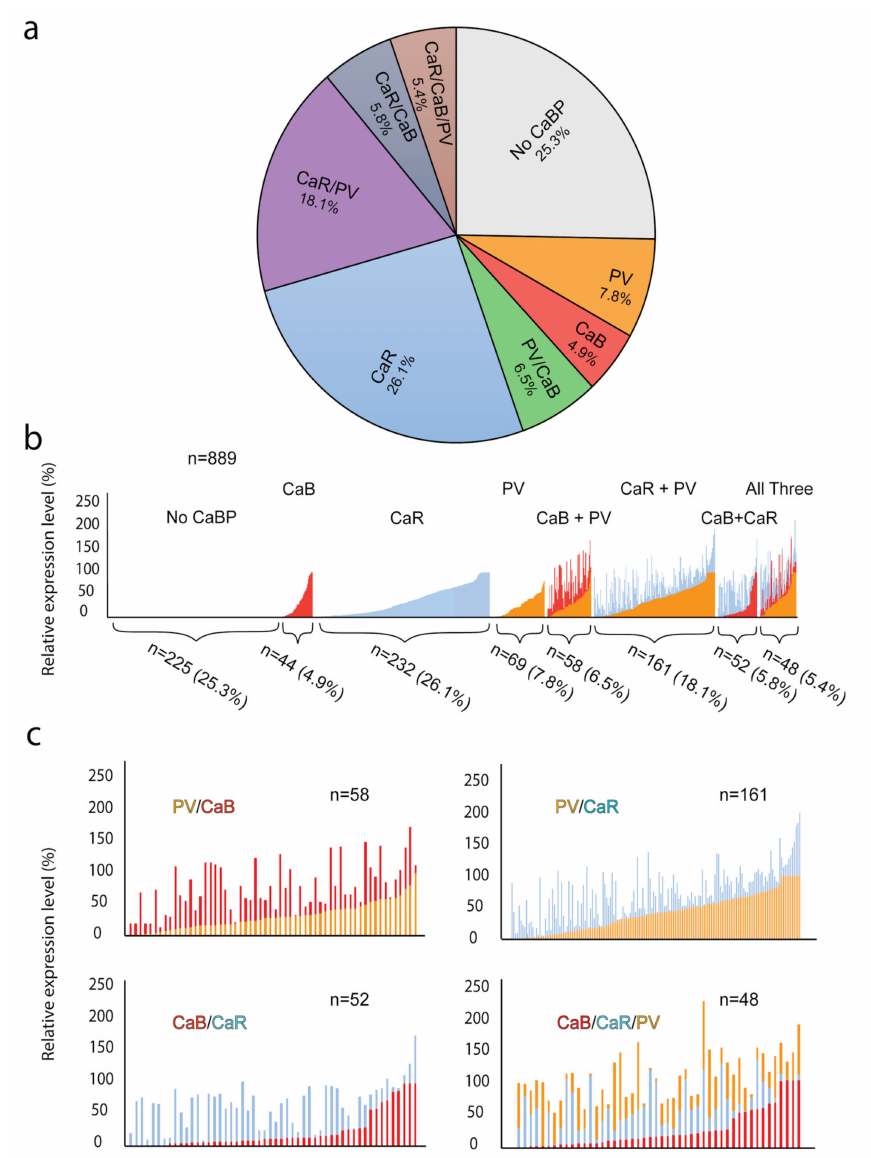
Figure 7. Comparison of multiple CaBP expressions in triple-labeled cells. Panel ( a ) showing a pie chart representing the ratios of the RGCs on the basis of CaBP expression (none, singularly, double and triple expressing) for the RGCs in our sample. Panel ( b ) is a stacked bar-chart, where the y -axis is the relative expression level of the three studied CaBP (CaB = red, CaR = blue, PV = orange). A closer view of the double and triple expressing population can be seen in the panel labeling individual cellular expression of CaBPs ( c